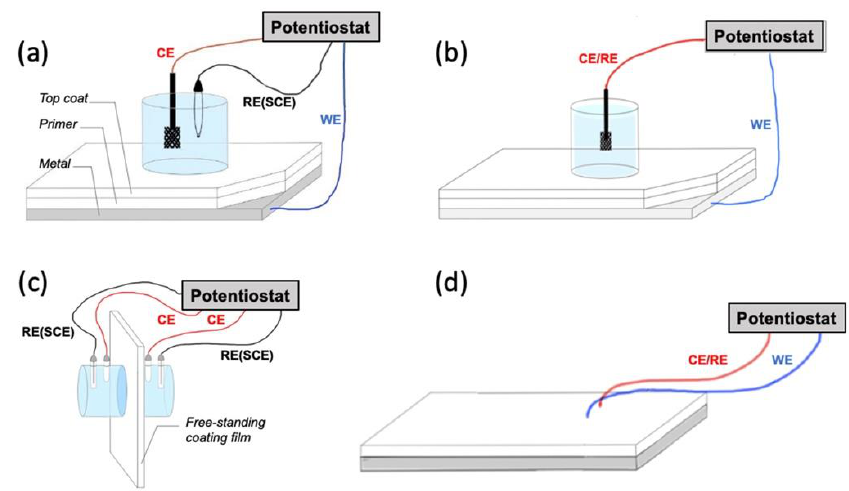
Figure 8. The evolution of configurations used for EIS measurements ( a – d ). (Personal drawing; inspiration from [73,74]).